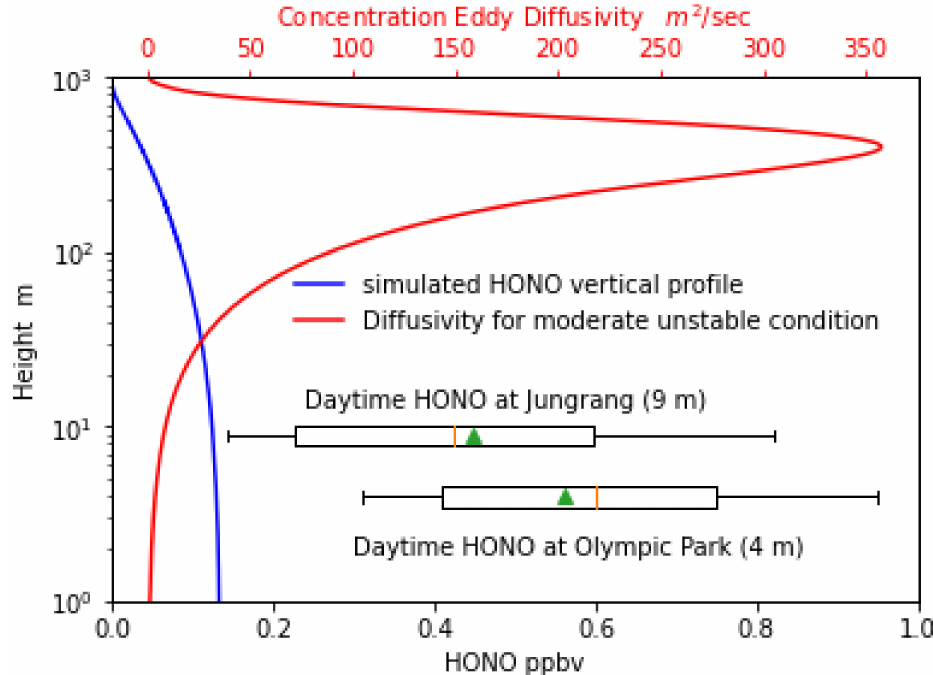
Figure 5. Estimated HONO concentration vertical diffusivity in red color and calculated vertical profile of daytime HONO in blue color compared with measured HONO of means (green triangle), medians and percentiles (10th, 25th, 75th, and 90th) for two field observations in Seoul, both with heights on logarithmic